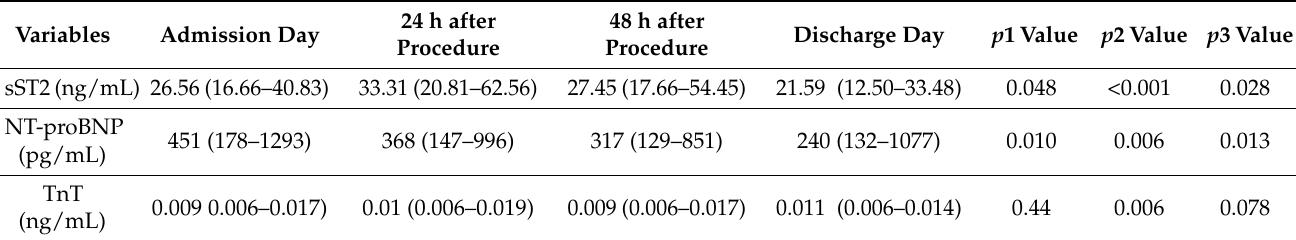
Table 2. Biomarkers measurements at four time points in the general study